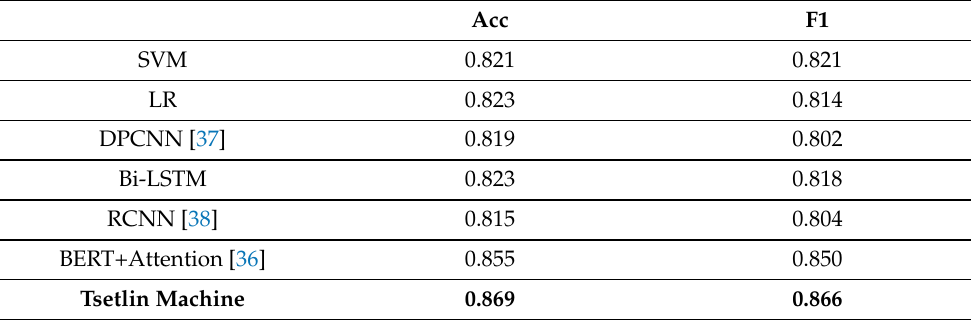
Table 7. Result of Spam Review Detection.